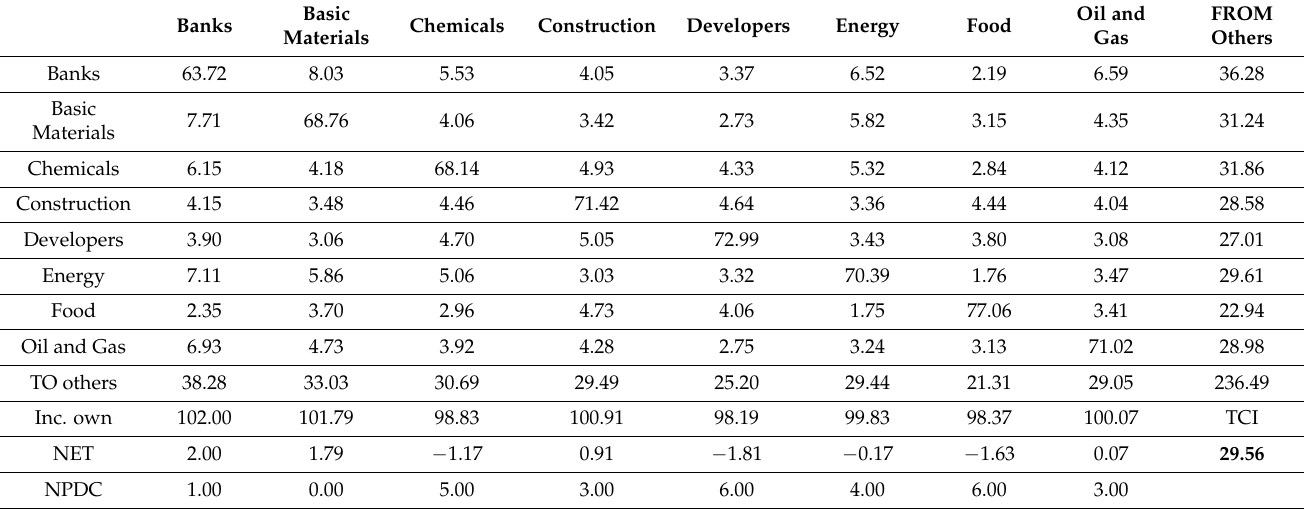
Table 5. Total volatility spillover for the period of 1 January 2013 to 31 December